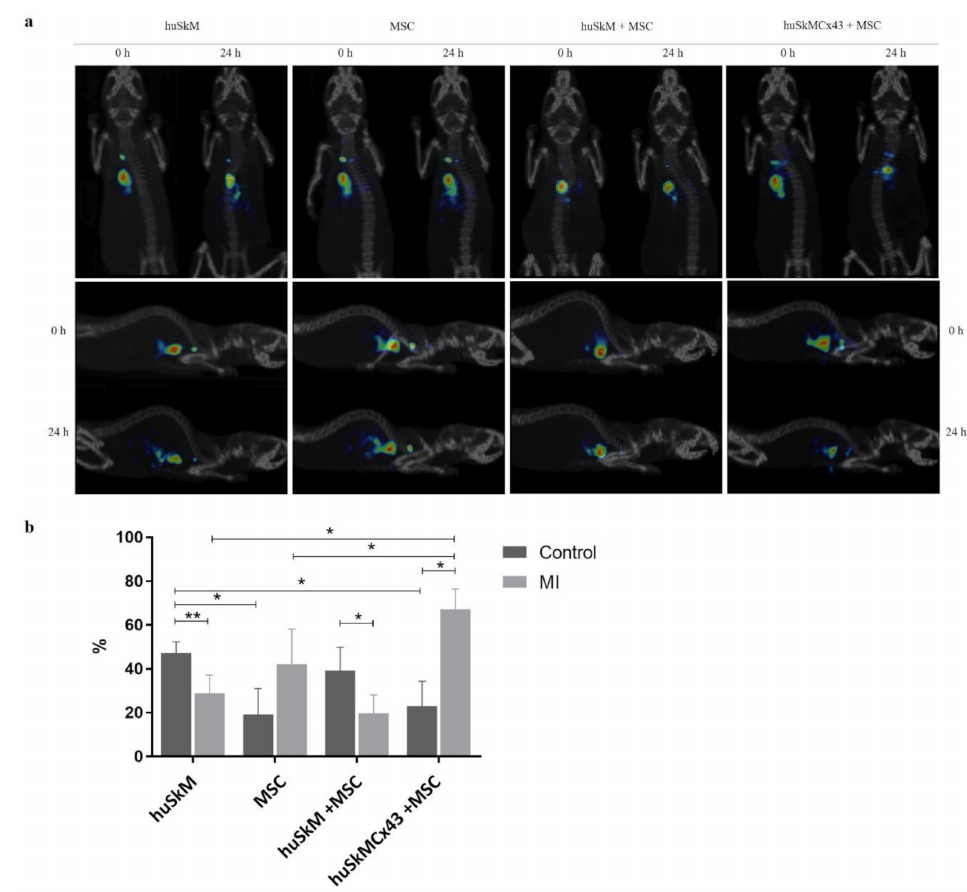
Figure 5. ( a ). 3D SPECT/CT images of various cell combinations labelled with [ 99m Tc]Tc-HMPAO administered intramyocardially. Images were acquired at 0 min and after 23 ± 1 h. ( b ). The efficiency of the colonization of stem cells (huSkM, MSC, huSkM + MSC, huSkMCx43 + MSC) labelled with [ 99m Tc]Tc-HMPAO at 24 h in post-infarction mice (healthy hearts: huSkM n = 7, MSC n = 8, huSkM + MSC n = 4, huSkMCx43+MSC n = 4; post-infarction hearts huSkM n = 8,